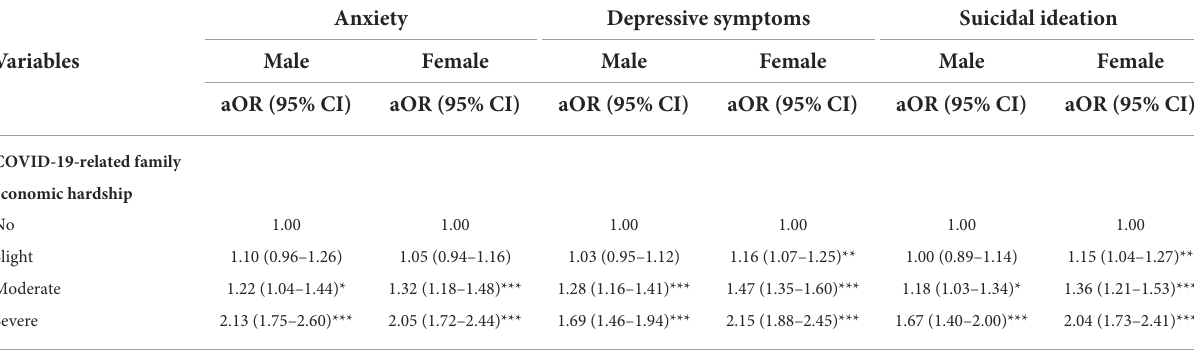
TABLE 3 Sex-based association between COVID-19-related family economic hardship and mental health (Male N = 28,353; Female N = 26,595). Anxiety Depressive